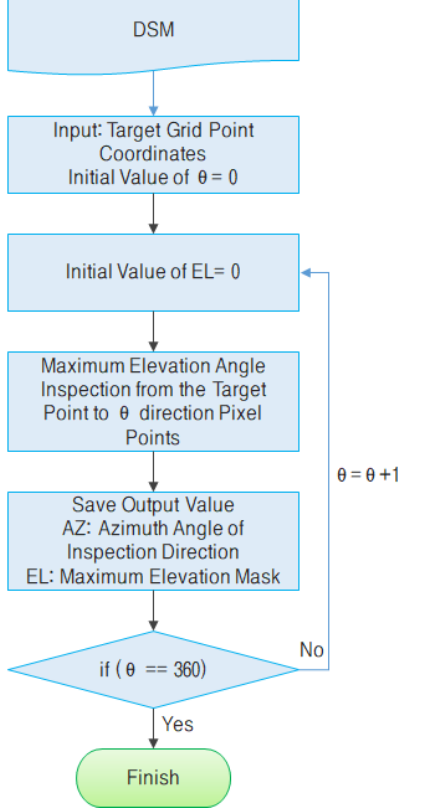
Figure 1. Flow chart of EMP generation algorithm